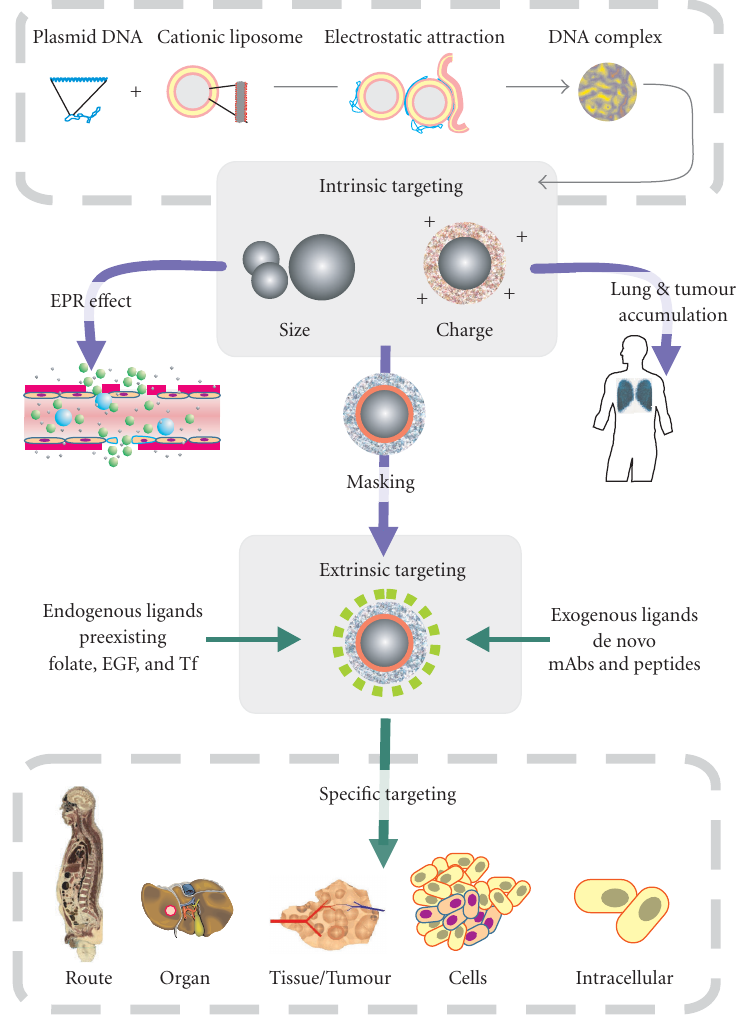
Figure 1. Targeting of synthetic vector systems. Schematic summary of factors important for the specific targeting of synthetic gene delivery systems. The mechanism of DNA packaging by cationic vectors, for example, vesicle, leads to the formation of condensed particles, which carry a positive charge. Particle size and charge are intrinsic physicochemical properties of these DNA complexes that, in interaction with the body, result in a modified biodistribution (eg, lung or tumour accumulation). In order to allow the use of more specific ligands, intrinsic targeting functions need to be masked, for example, by coating with hydrophilic polymers. These more inert carriers can then be directed specifically to a remote target site through the use of endogenous or exogenous ligands to allow targeting of di ff erentials between target site and healthy tissue on various